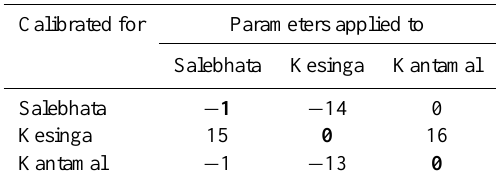
Table 7. Like Table 6 but numbers represent the percentage bias (Eq. 5). Calibrated for Parameters applied